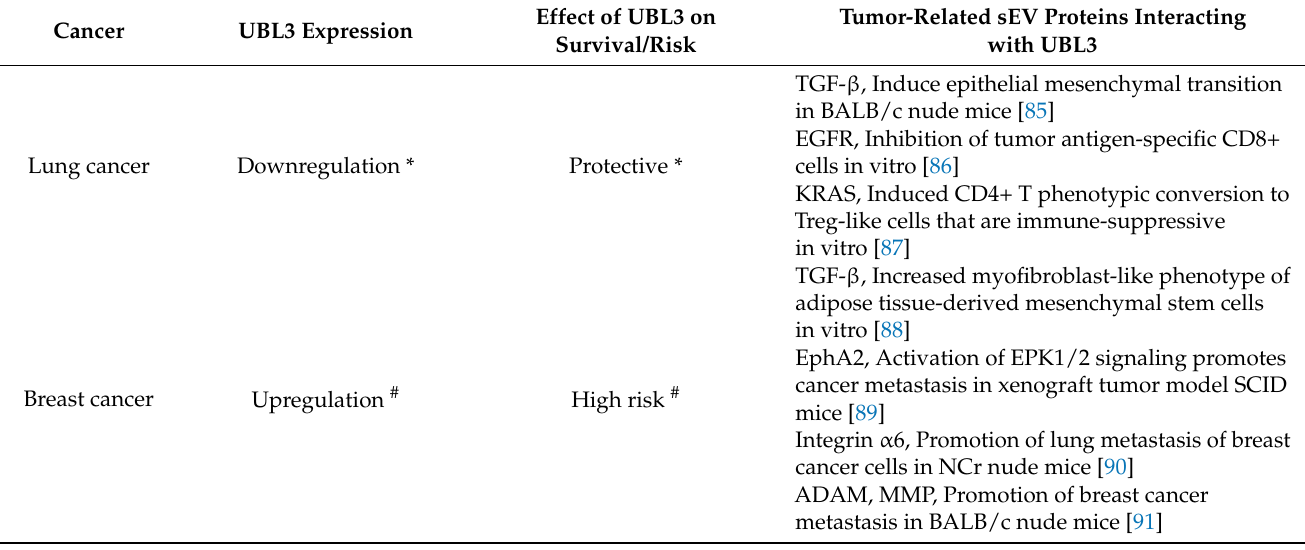
Table 2. Summary of the relationship between UBL3 and